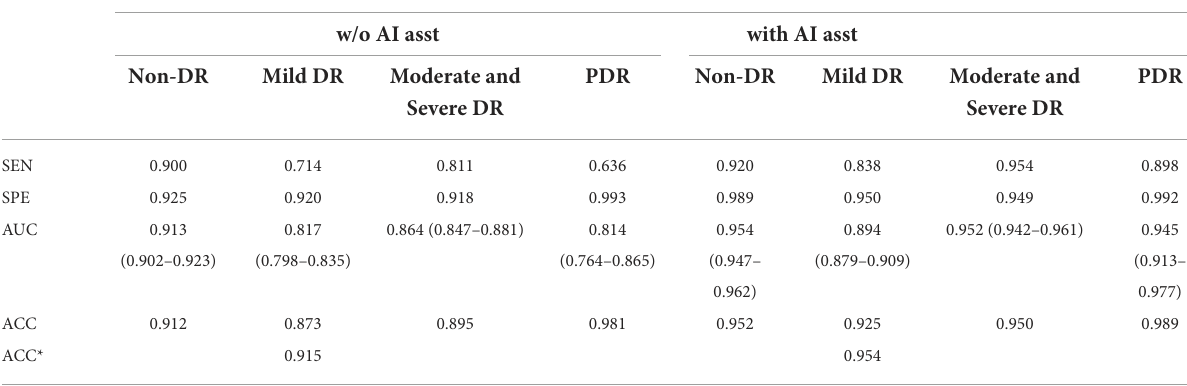
TABLE 5 Manual detection of diabetic retinopathy based on ICDR grading system by the medical